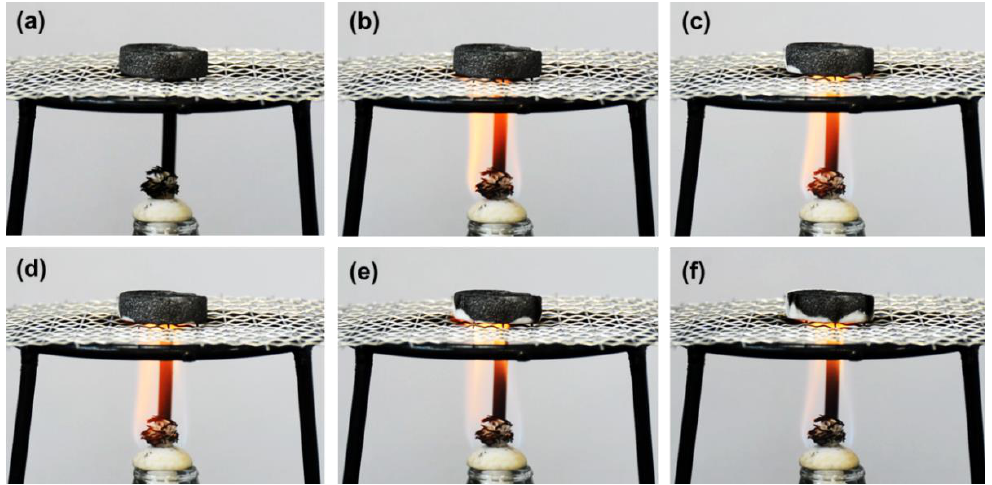
Figure 6. Flame-resistance studies with GSA-10. ( a – f ) Visual configurations of the GSA sample after 10, 20, 30, 40, and 50 min, respectively, of ablation tests in air condition with alcohol lamp.